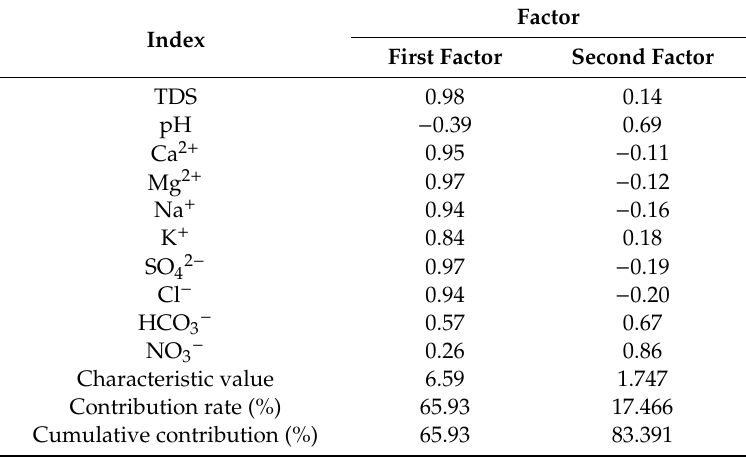
Table 5. Rotated component